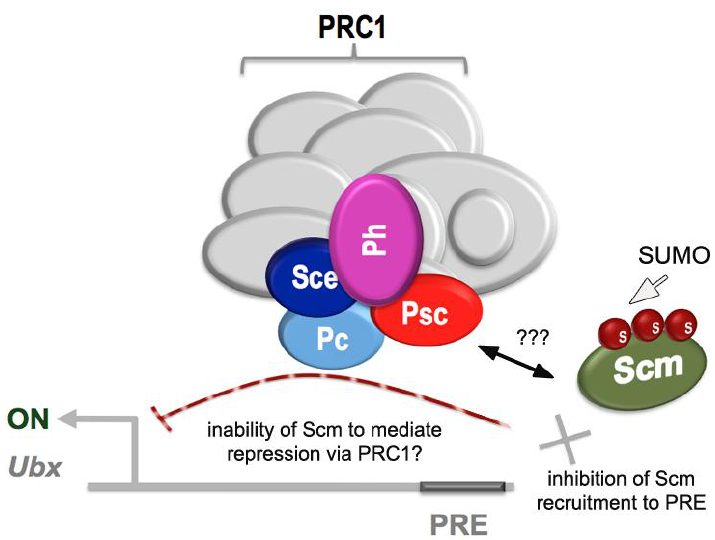
Figure 1. Role of SUMOylation in Sex comb on midleg (Scm) protein function. SUMOylation (S) of Scm blocks its recruitment to the Ultrabithorax (Ubx)